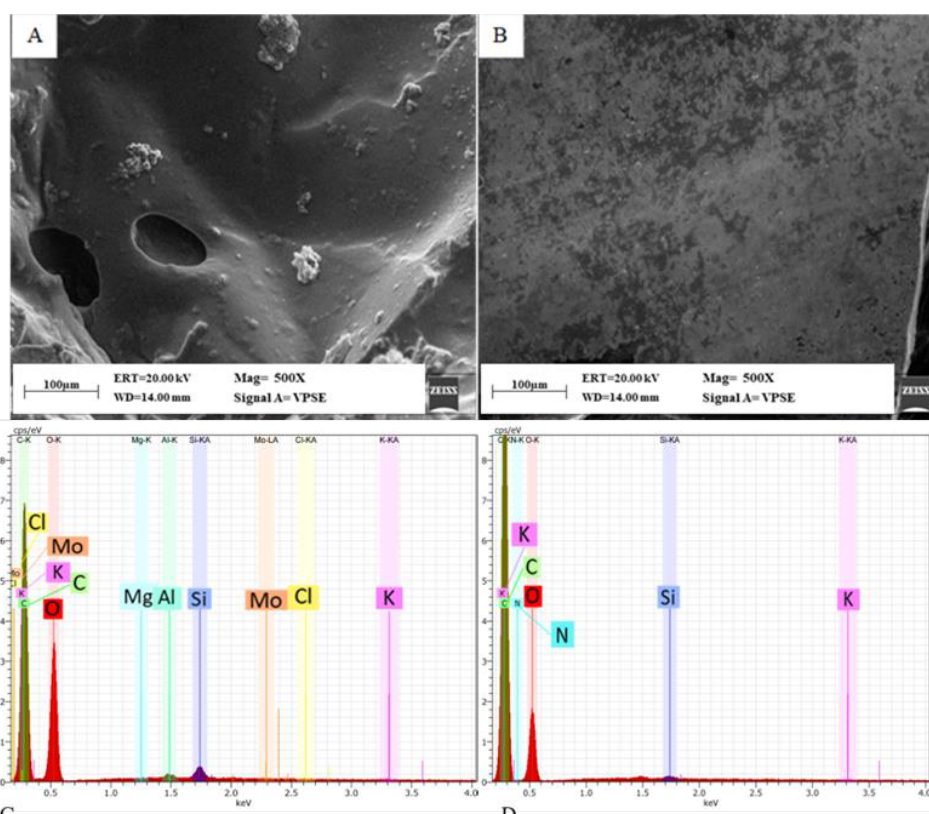
Figure 8. SEM micrographs (scale bar 100 µ m, Mag = 500 × ): ( A ) CL-HEC8 and ( B ) CL-SA8 samples as examples of crosslinked hydrogel surface. EDX analysis 0–4 kev on ( C ) CL-HEC8 and ( D ) CL-SA8 samples.